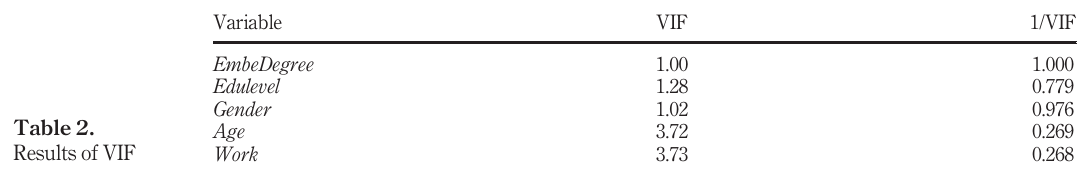
Table 2. Results of